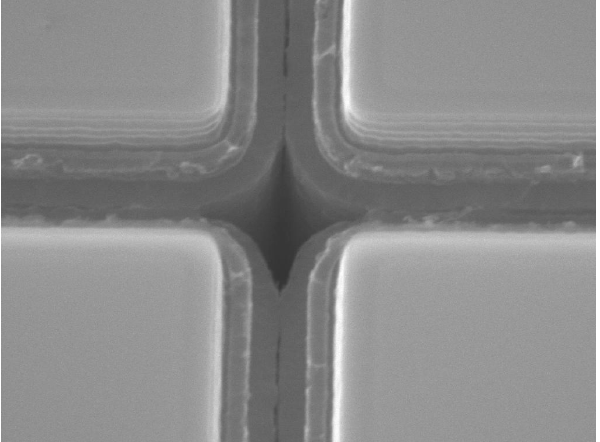
Figure 12. SEM image of SiPMs during the fabrication process, after the trench-filling step. Trenches are filled with SiO 2 and highly doped polysilicon.